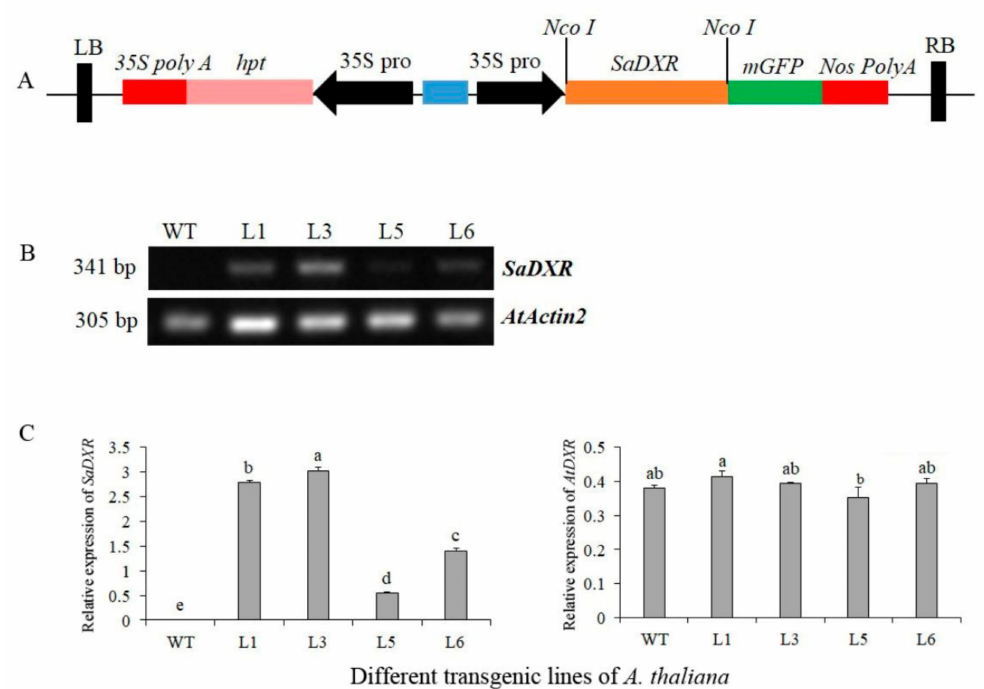
Figure 8. Overexpression of SaDXR in A. thaliana. ( A ) Schematic representation of the 35S::SaDXR overexpression vector. ( B ) Gene expression analysis of SaDXR in wild-type (WT), i.e., control, and in select transgenic lines of A. thaliana by using semi-quantitative PCR. ( C ) Expression level of SaDXR and AtDXR in WT or transgenic A. thaliana seedlings by qRT-PCR. WT did not give a signal as the primers are specific to SaDXR. Each value represents the means of three independent biological replicates ± SD. Different letters above bars indicate significant differences (DMRT, p < 0.05).